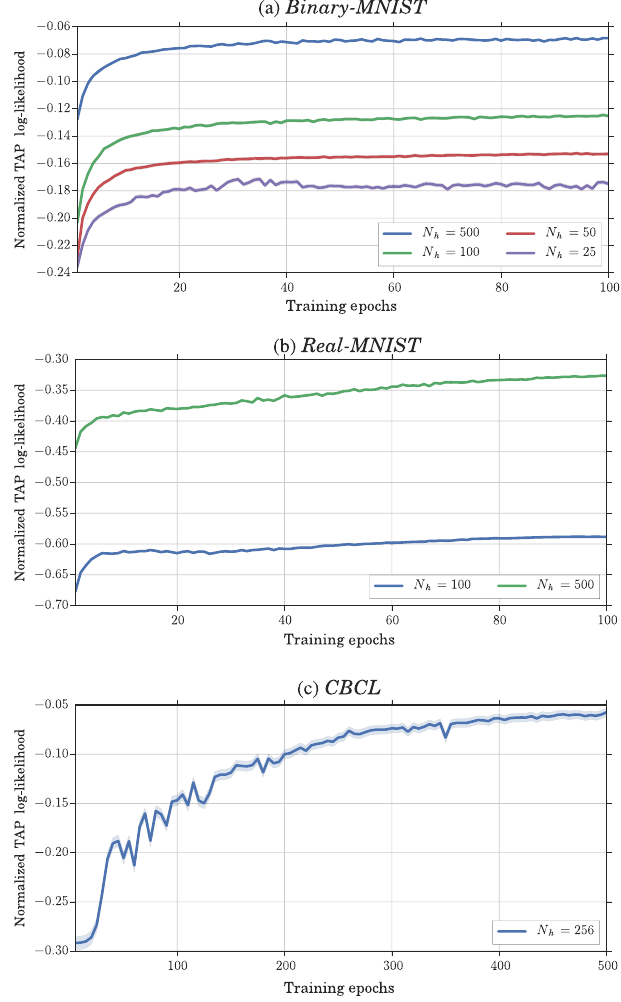
FIG. 3. Training performance over 100 epochs for the tested data sets over varying numbers of hidden units, N h . Performance is measured in terms of the normalized (per-unit) TAP log- likelihood estimate computed for 10 000 training data samples. The TAP free energy is estimated using the unique TAP solutions thermalized from initial conditions drawn from the data samples, as in Eqs. (37) and (38). Thermalization is determined by the convergence of the magnetizations up to a difference of 10 − 8 in MSE between iterations. Solid lines indicate the average nor- malized TAP log-likelihood over the tested training samples, and shaded regions indicate standard